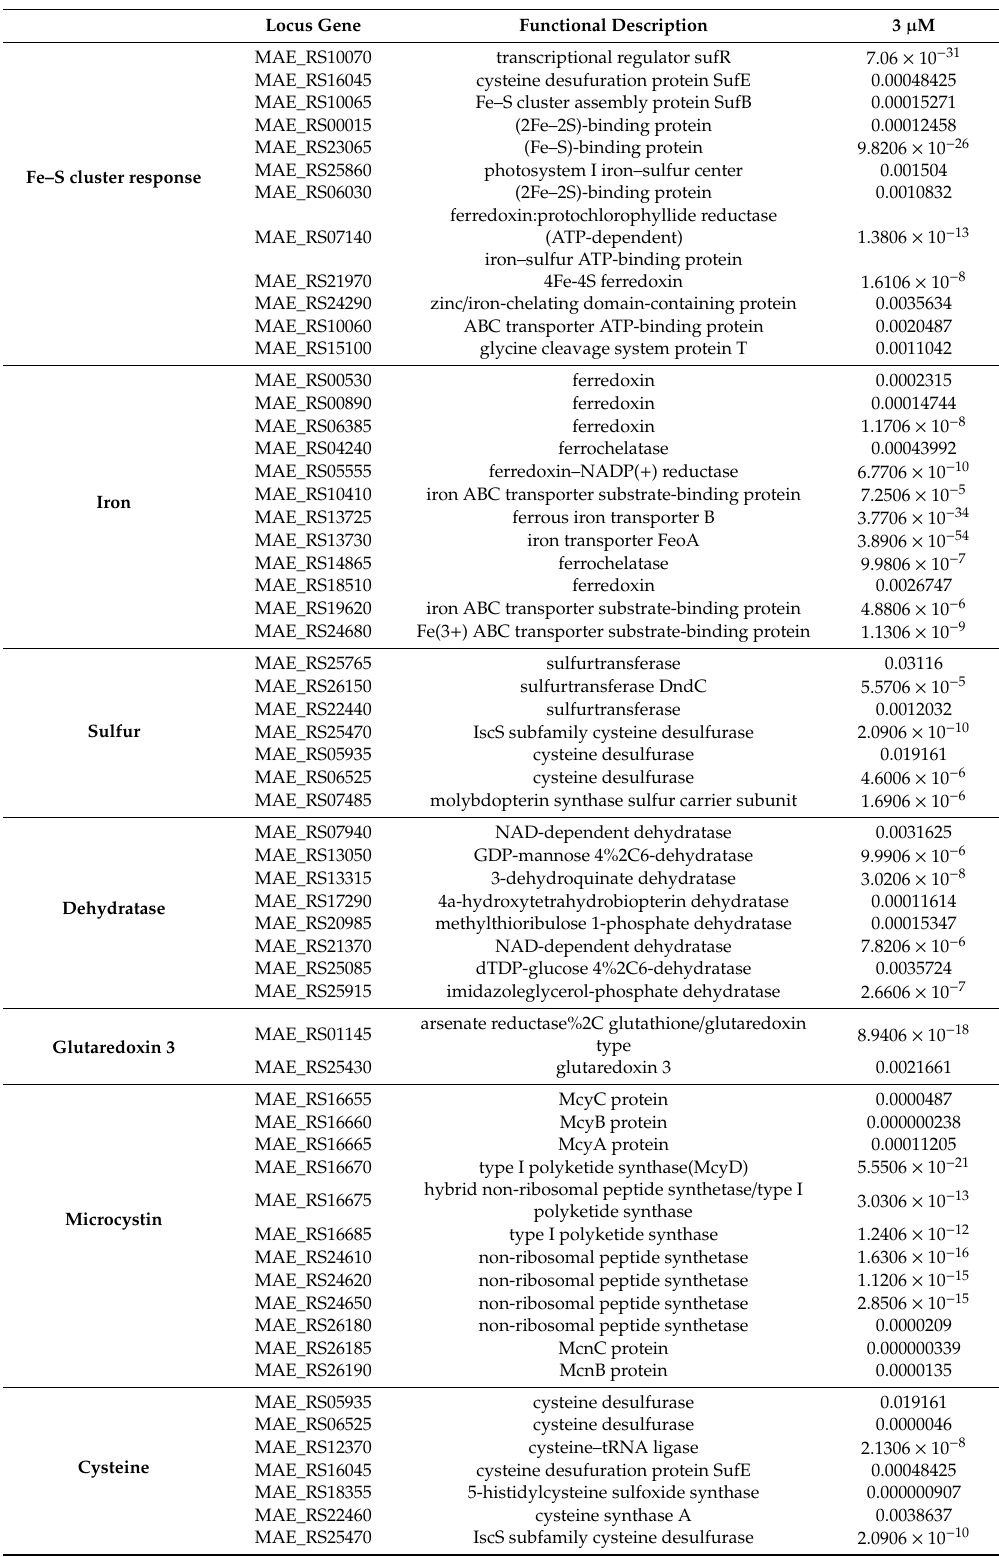
Table A2. Selected genes induced in M. aeruginosa PCC 7806 after the high-copper treatment at 3 µ M: the addition of freshly prepared 3 µ M CuSO 4